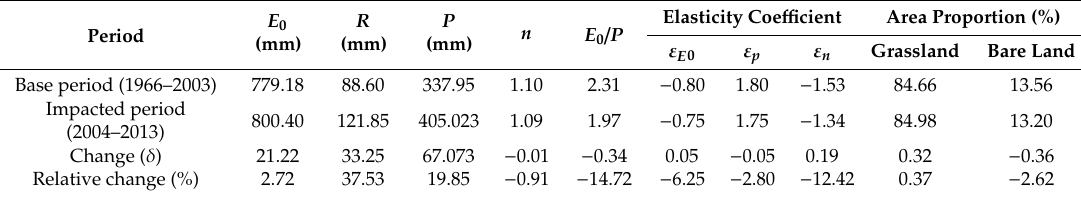
Table 3. Sensitivity of R to P , E 0 and n during 1966–2003 (base period) and 2004–2013 (Impacted period) in the YRHA.